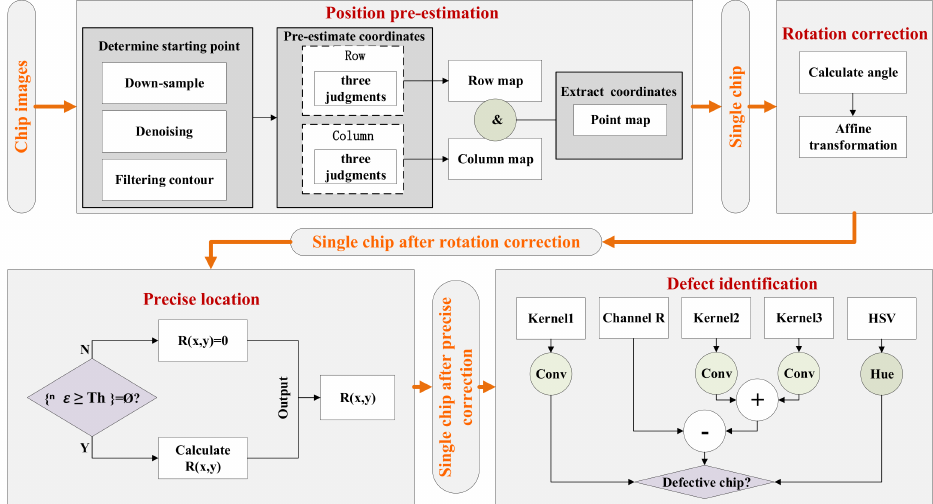
Figure 3. Process of defect